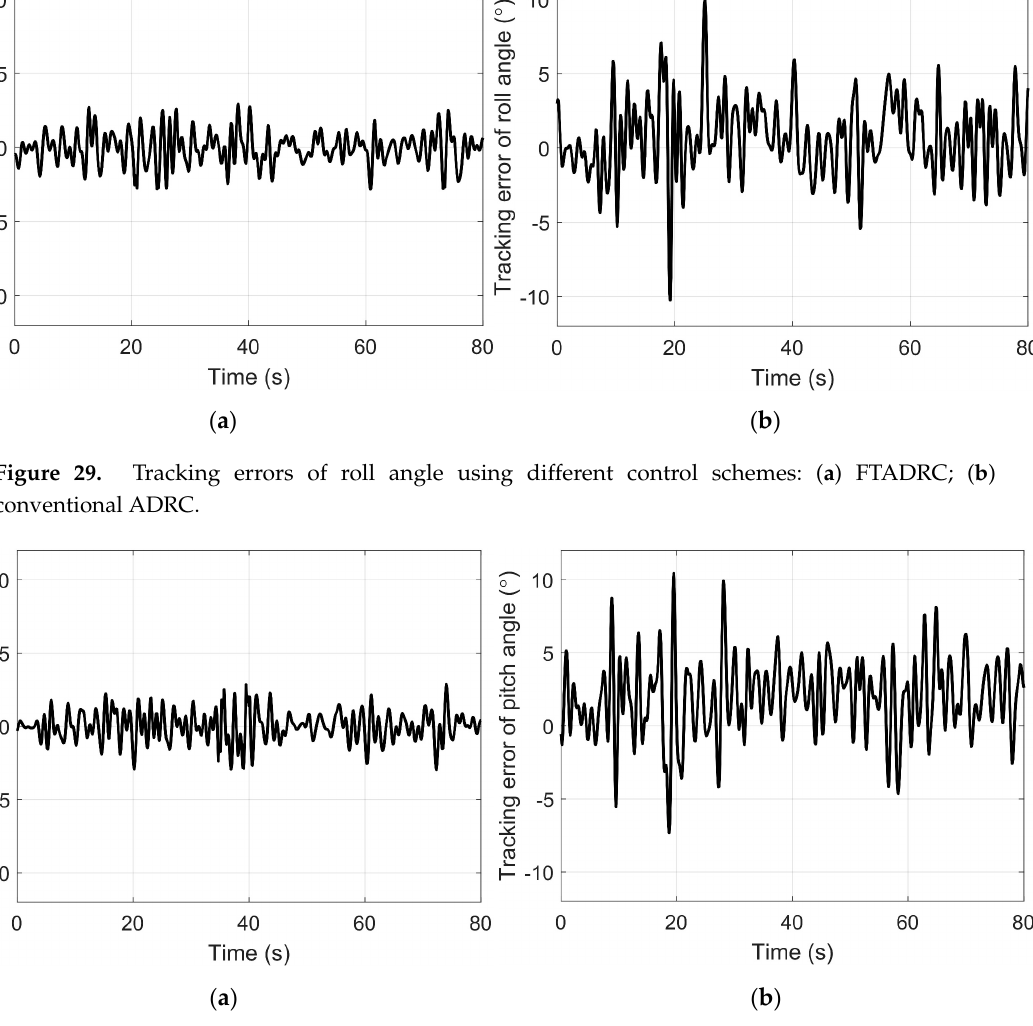
( b ) Figure 31. Tracking errors of yaw angle using different control schemes: ( a ) FTADRC; ( b ) conventional ADRC. ( a ) ( b ) Figure 32. Curves of disturbance estimation using different control schemes: ( a ) FTADRC; ( b ) conventional ADRC.